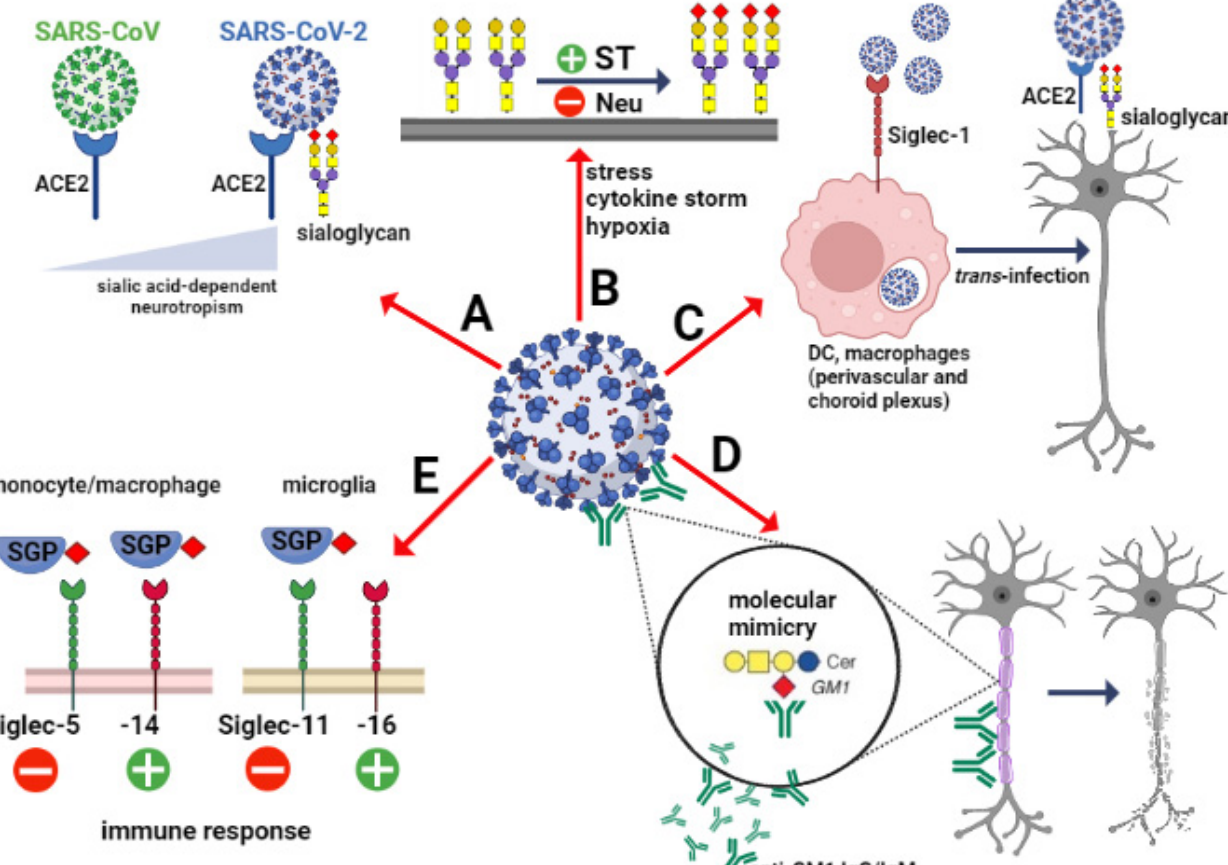
Figure 1. The engagement of sialic acid-dependent mechanisms in SARS-CoV-2 invasion in the human CNS. The ability to recognize and bind to the sialoglycans of the host determines the viral tropism to sialic acid-rich brain tissue ( A ). In response to viral infection-related hypoxia and cytokine storm, changes in the balance between sialyltransferases and neuraminidases lead to qualitative and quantitative alterations in cellular glycome ( B ). Siglec-1 on macrophages and dendritic cells interacts with sialylated glycans exposed on SARS-CoV-2, mediates its endocytosis and replication, and boosts viral transmission to neurons ( C ). The structural identity of sialoglycans expressed on the virus and host cells leads to neuronal degeneration as a result of the autoimmune process ( D ). The SARS-CoV-2 envelope sialylated glycans and sialylated secreted glycoproteins interact with Siglecs on the host cells, resulting in immune responses of different intensity ( E ); ACE2—Angiotensin-converting enzyme-2, ST—Sialyltransferases, Neu—Neuraminidases, DC—Dendritic cells, SGP—Sialylated secreted glycoprotein, GM1—Ganglioside